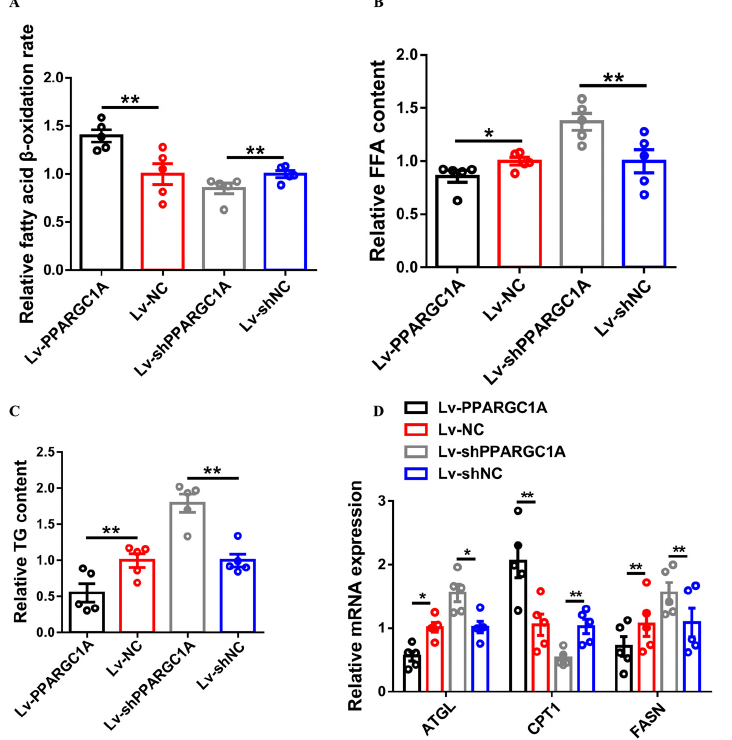
Figure 3. PPARGC1A accelerates intramuscular fatty acid oxidation. ( A ) to ( D ), relative fatty acid β –oxidation rate ( A ), relative free fatty acid (FFA) content ( B ), relative triglyceride (TG) content ( C ), and relative mRNA expression levels of fatty acid oxidation or synthesis–related genes ( D ) in gastrocnemius with PPARGC1A overexpression or under–expression. Results are presented as mean ± SEM. In all panels, statistical significance of differences between means was assessed using paired t –tests. (* p < 0.05; ** p <